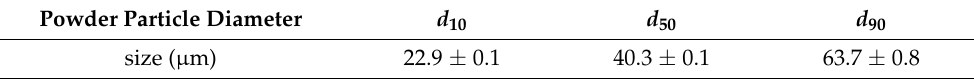
Table 2. Powder size distribution of the as-received powder fraction. Powder Particle